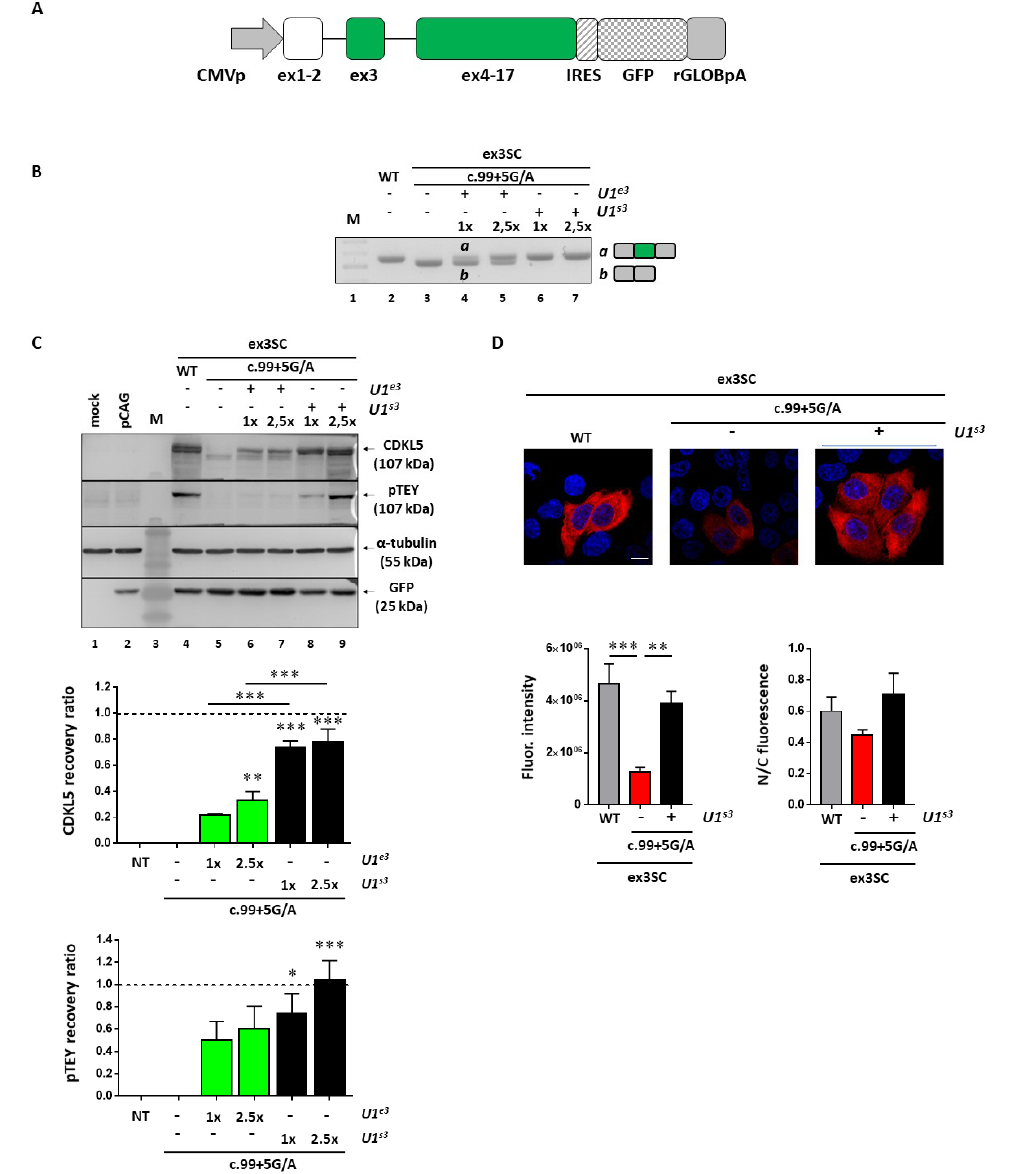
Figure 5. U1-mediated rescue of CDKL5 expression at the protein level. ( A ) Schematic representation of the full-length splicing-competent CDKL5 expression cassette (CDKL5SC) used to evaluate the U1- mediated rescue of the c.99+5G>A mutation. ( B ) RT-PCR evaluation of the CDKL5 splicing patterns in HEK293T cells transiently transfected with CDKL5SC alone or in combination with modified U1snRNAs (the compensatory U1snRNA (U1 s3 ) and the ExSpeU1 (U1 e3 )). The schematic representation of the transcripts is reported on the right. ( C ) Western blotting analysis of U1-mediated rescue of CDKL5 expression and phosphorylation of its TEY motif in lysates of HEK293T cells transfected as in ( B) . The histograms show the mean ± SEM of the expression levels of full-length CDKL5 (above) normalized to GFP and TEY phosphorylation (below), calculated as a ratio between phospho-TEY and total CDKL5, in cells transfected with modified U1snRNAs (U1 e3 and U1 s3 ) and compared to cells transfected with c.99+5G/A mutant cDNA. NT indicates not transfected cells. α- tubulin served as loading control. Data were analyzed by one-way ANOVA, followed by Tukey’s multiple comparison test. When not properly indicated, asterisks denote a significant difference